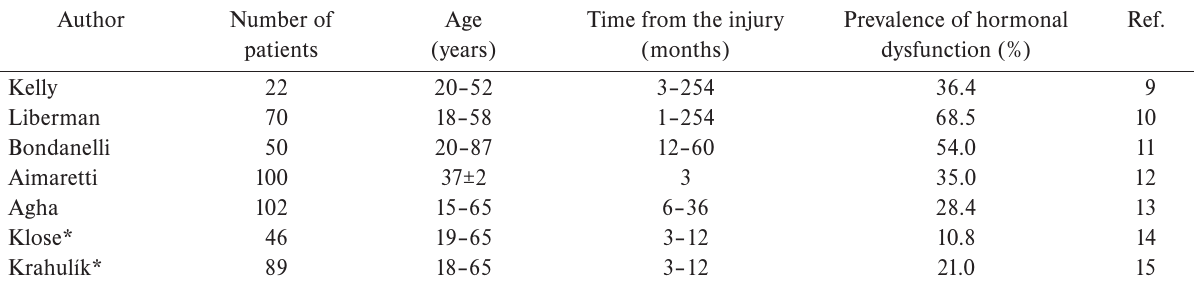
Table 1. Post-traumatic hypopituitarism in adults.